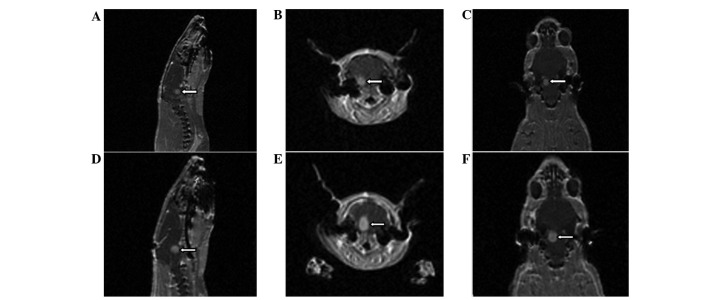
Tumors in (A–C) juvenile and (D–F) adult rats. The signals of the tumors were low in the T1WIs and high in the T2WIs. Following the injection of Gd-DTPA, the signal in the T1WIs was clearly enhanced, revealing necrosis inside the tumors. The tumors exhibited marked mass effects, resulting in ventricular dilation where the tumor was obstructing the pathway of the CSF. Arrows indicate the tumor. T1WI, T1-weighted image; Gd-DTPA, gadolinium diethylenetriamine pentaacetic acid; CSF, cerebrospinal fluid.